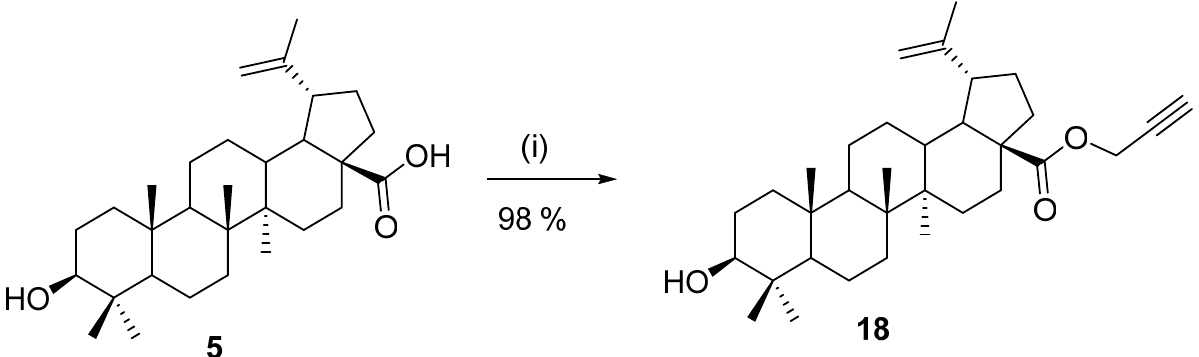
Esters of betulinic acid ( 5 ) at their 28-COOH group can also be prepared by alkylation